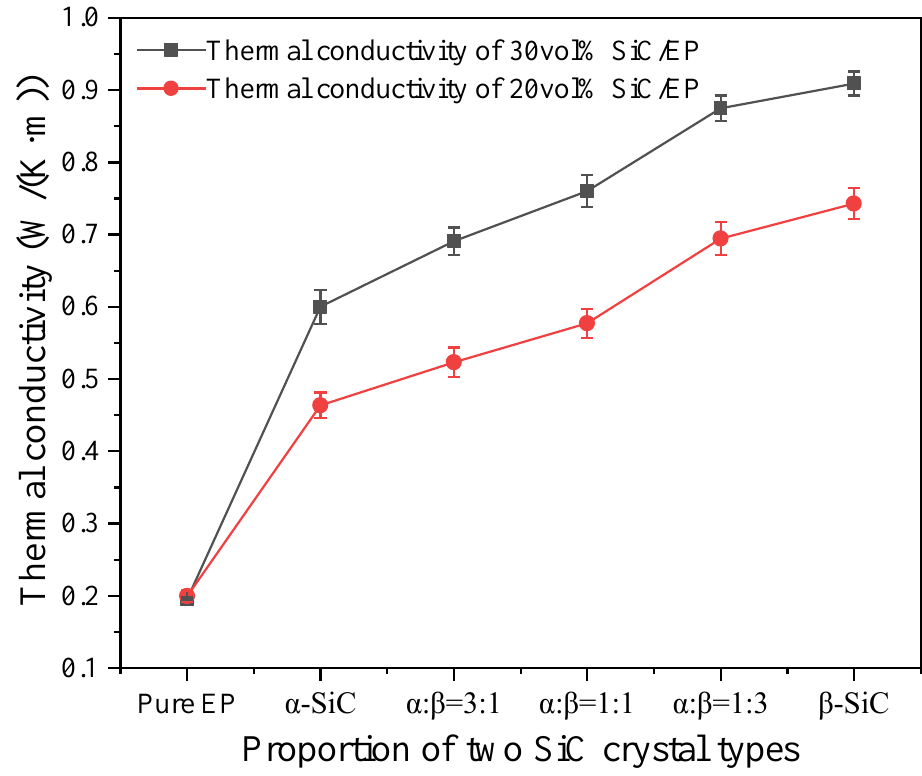
Figure 9. Thermal conductivity of SiC composite filled with different crystal forms.